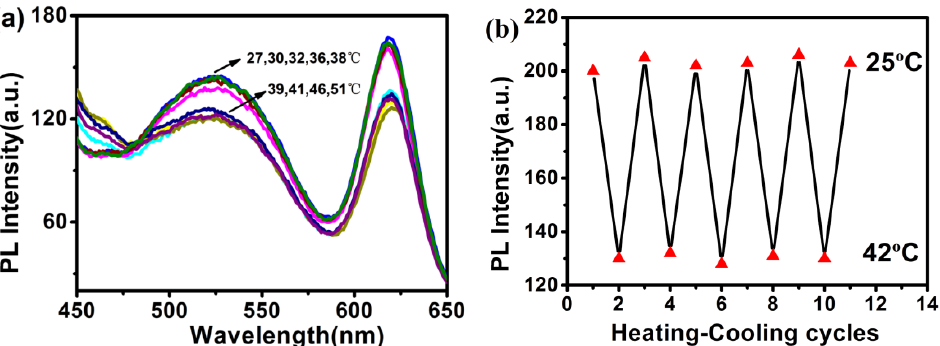
Figure 11. Evolution of fluorescence spectra as a function of temperature for QDs/polymer/GO fluorescence nanohybrid ( a ) and corresponding cycles of heating–cooling at above and below LCST of QDs/polymer/GO ( b ).